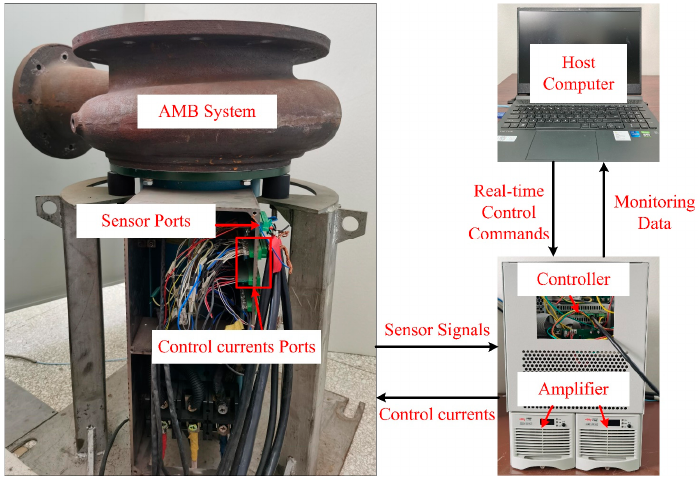
Figure 9. Experimental setup of the AMB system.